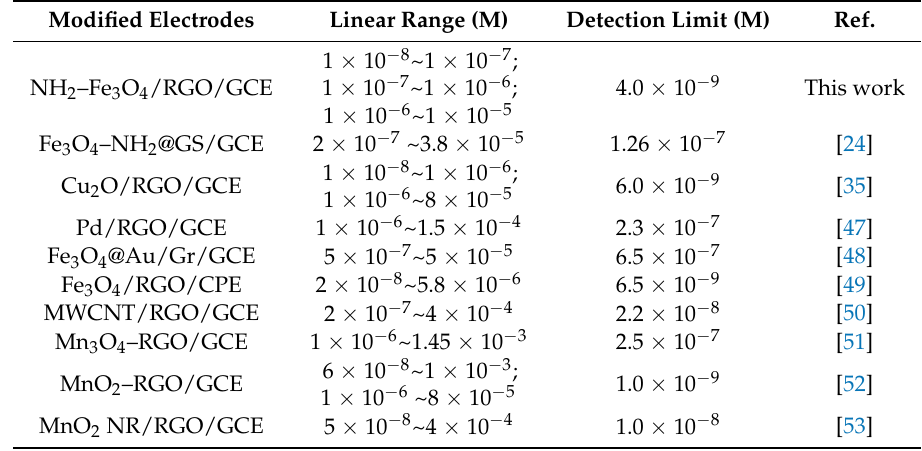
Figure 11. Calibration curves between response peak currents and the concentration of DA. The concentration ranges are 1 × 10 − 8 – 1 × 10 − 7 mol/L ( A ), 1 × 10 − 7 – 1 × 10 − 6 ( B ) and 1 × 10 − 6 – 1 × 10 − 5 mol/L ( C ). Table 1. A comparison of the sensing performance between NH 2 –Fe 3 O 4 /RGO/GCE and other modified electrodes reported in